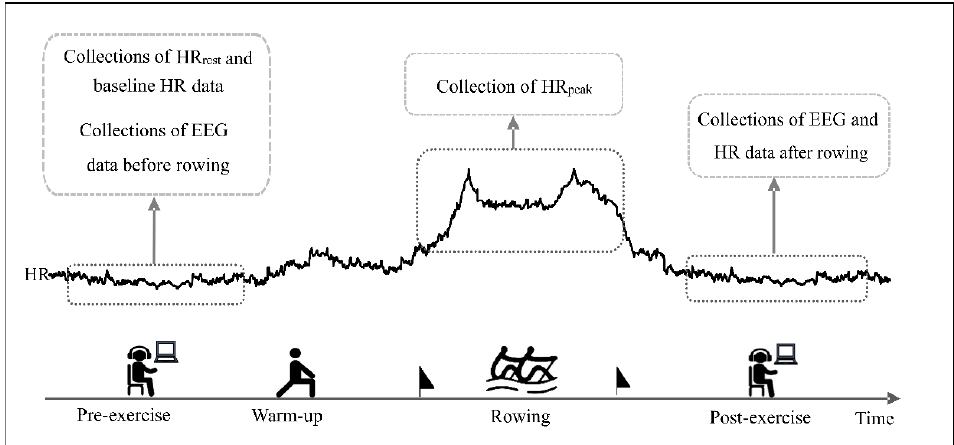
Figure 1. Experimental protocol. HR: heart